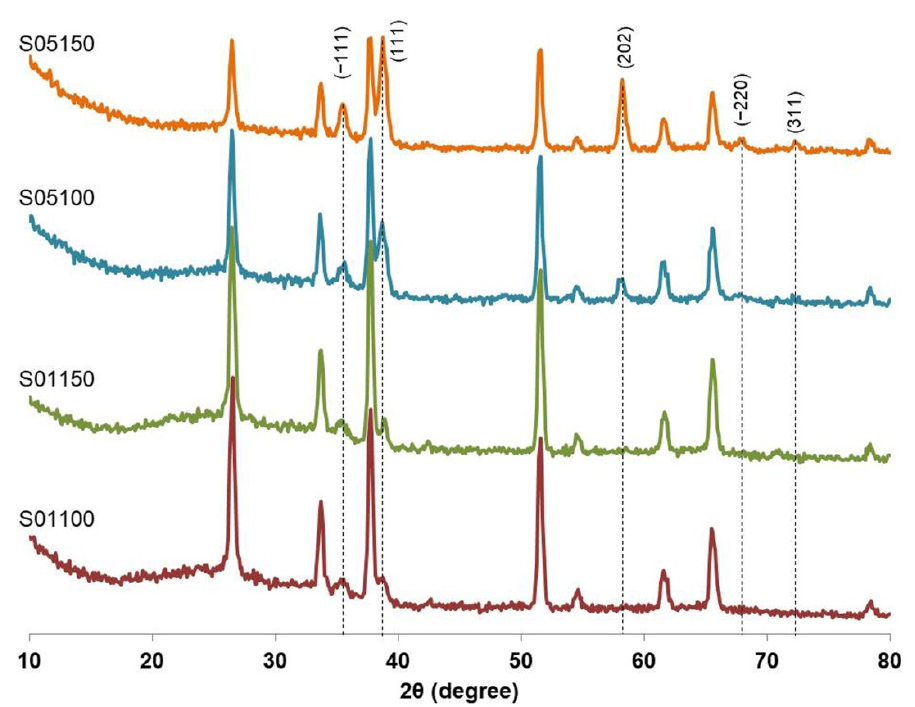
Figure 1. XRD patterns of S01100, S01150, S05100, and S05150 samples prepared on FTO substrate. The CuO thin films were synthesized by hydrothermal method at 100 °C and 150 °C for 12 h.